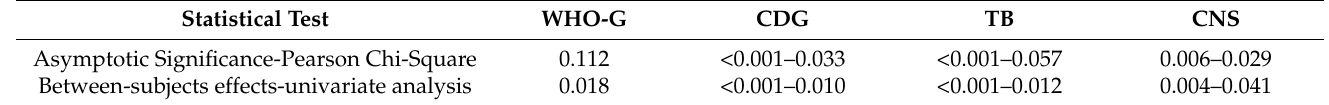
Table 2. Relationship with